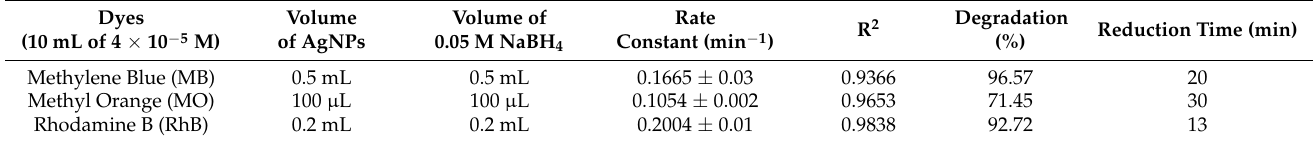
Table 3. A Comparative study table for catalytic degradation of dyes using